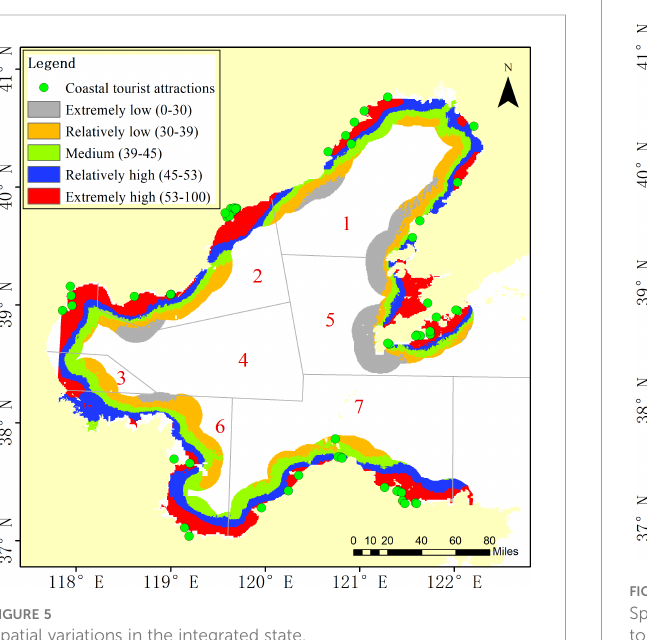
FIGURE 7 Spatial variations in the integrated vulnerability of the coastal tourist